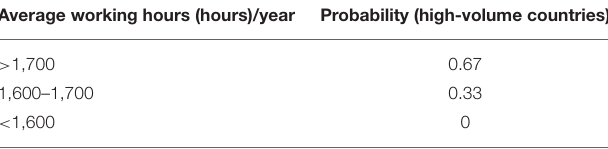
TABLE 5 | Probability of countries with high smart bed sales in different working time